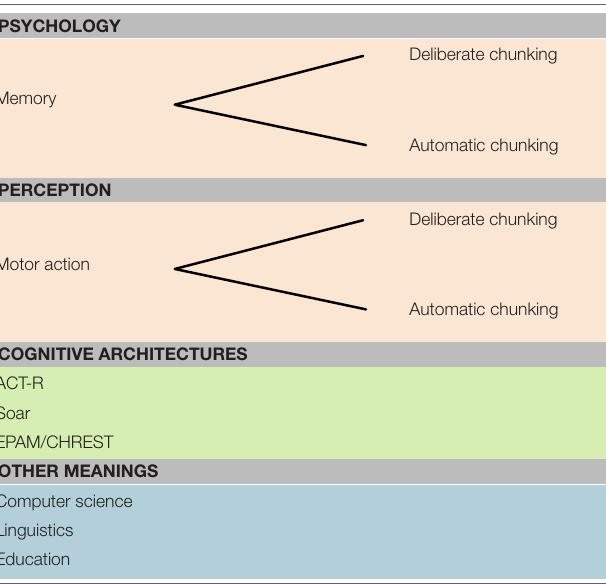
TABLE 1 | A taxonomy of the meanings of “chunk” and